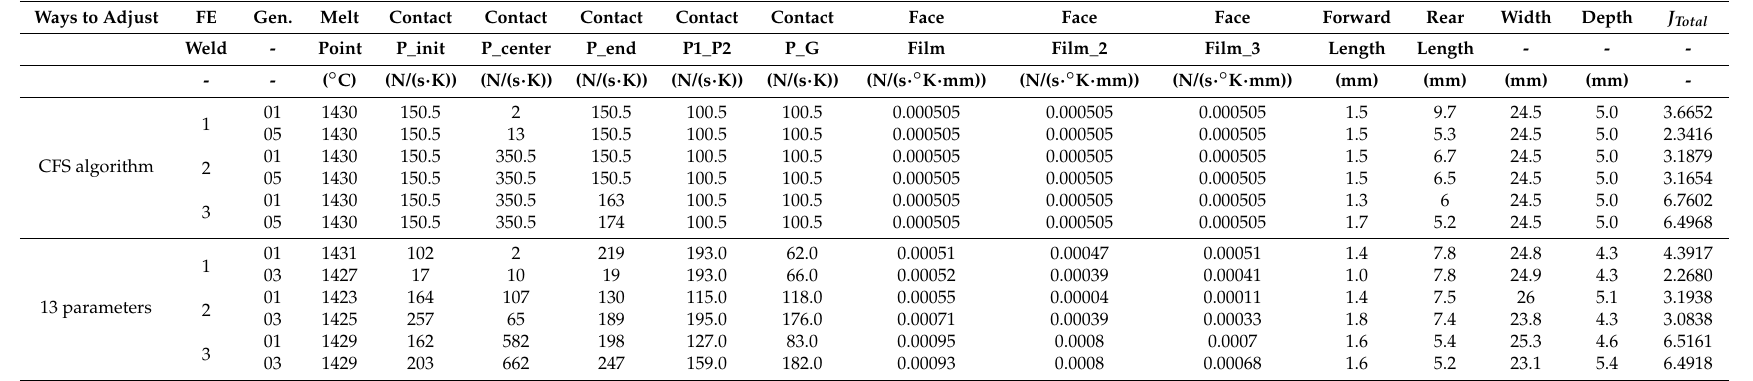
Table 5. Results of the adjustment process for the three welded joints FE models: considering the 13 input parameters and considering the selected parameters by the CFS filter